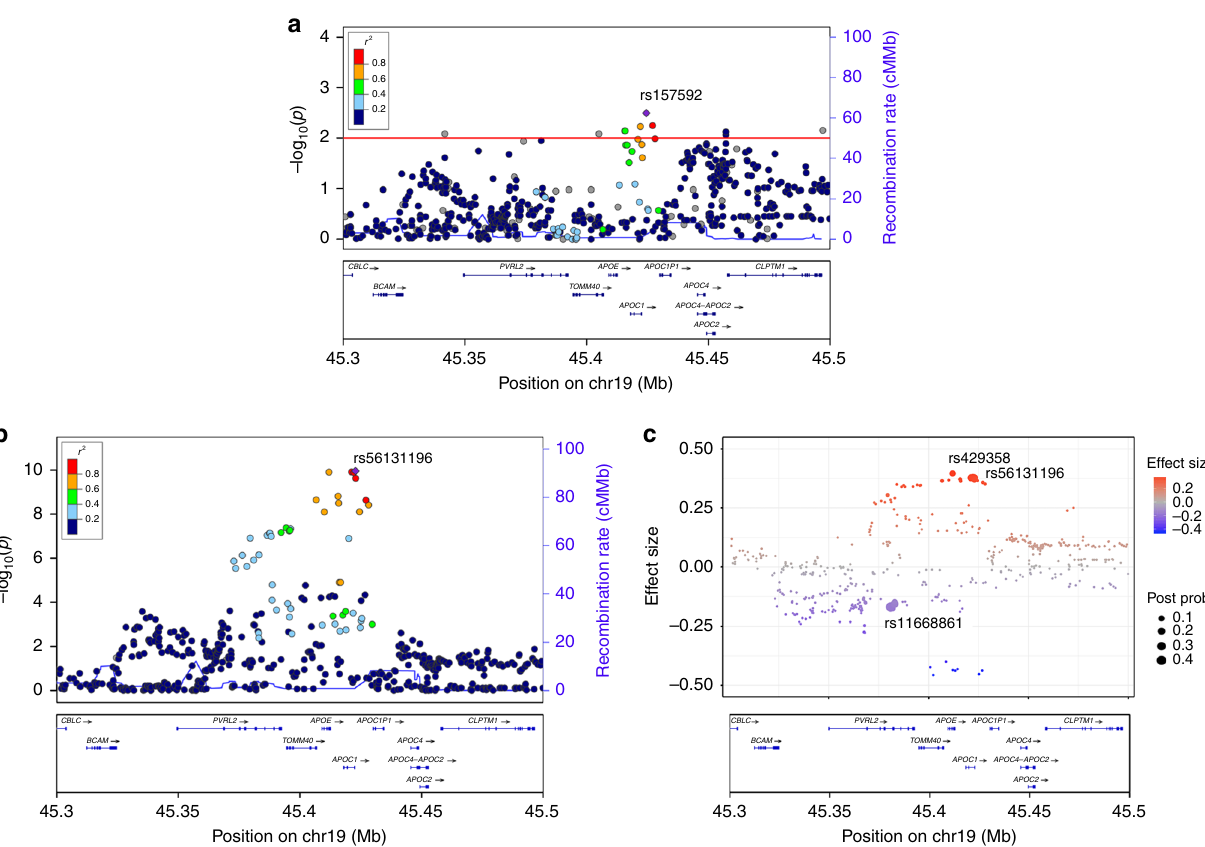
Fig. 1 Multivariant effects of the APOE locus in the Chinese AD cohort. a Regional association plot of the AD risk variants in APOE - ε 3 homozygous subjects. The horizontal red line denotes the p -value threshold of 0.01. b Regional association plot of the AD risk variants (SNPs and INDELs with frequency ≥ 5%) located in the APOE locus. The purple diamond speci fi es the sentinel variant (with the SNP ID marked in the plot). Dot colors illustrate the LD (measured as R 2 ) between the sentinel variant and its neighboring variants. c CAVIAR analysis results for mapping of possible causal variants in the APOE locus. Dots represent the variants tested in the APOE locus; the y -axis and dot color denote the effect size. Dot size corresponds to the posterior probabilities of the variants being the causal variants obtained from CAVIAR analysis, with the sentinel variants located in three loci marked with SNP IDs. AD Alzheimer ’ s disease, CAVIAR causal variants identi fi cation in associated regions, cM/Mb centimorgans per megabase, INDELs insertions and deletions, LD linkage disequilibrium, SNP single nucleotide polymorphism, Post Prob posterior probabilities of being the causal variants Table 1 Potential causal variants in APOE and the surrounding region identi fi ed by CAVIAR